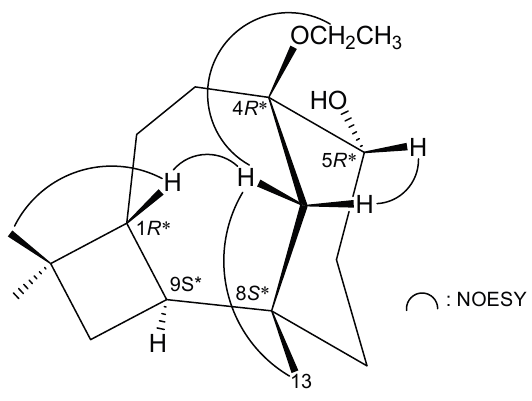
Figure 4. Selective NOESY correlations of 2